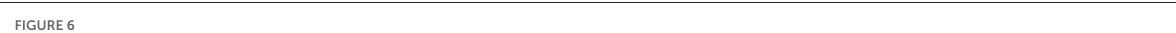
FIGURE6 (BP), (B) Cellular components (CC), (C) Molecular functions (MF), and (D) the KEGG pathways influenced by CBX family. The red box emphasized the functions that had the most count and significant difference in these analyses. (E) Clinical validation of CBX7 and CBX8 through immunochemistry staining in tumor-adjacent normal and GBM tissues. The black scale bar represented 4 µ m. N = 3. (* p < 0.05). (F,G) Western blots were performed to confirm the effectiveness of lentivirus transfection in U87 and U251 glioma cells. β -tubulin was set as the loading control. N = 3. (* p < 0.05). (H) Ki-67 immunofluorescent staining was performed to evaluate the effect of CBX7 and CBX8 on the proliferation capacity in glioma cells. The white scale bar represented 20 µ m. (I) The orthotopic U87 glioma model in nude mice measured the proliferation of glioma cells with intervention on CBX7 and CBX8. The subcutaneous tumor was photographed and measured at 0h and 28 days after injection using the formula: volume (mm 3 ) = length*width*height. N = 3. (J,K) Western blots were performed to assess the invasion-related markers by detecting the MM2 and MMP9. β -Tubulin was set as the loading control, N = 3, (* p < 0.05). (L) The wound-healing assay explored the invasion abilities of U87 glioma cells with different interventions on CBX7 and CBX8 compared to the control. The gap was measured at 0h and 24h after the scratch. The white scale bar represented 4 µ m. (* p < 0.05, ** p < 0.01, *** p <